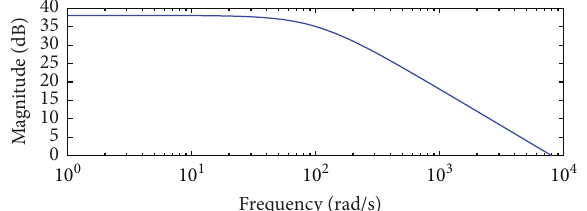
Figure 5: The frequency response of 𝑊 𝑝 (𝑠) .